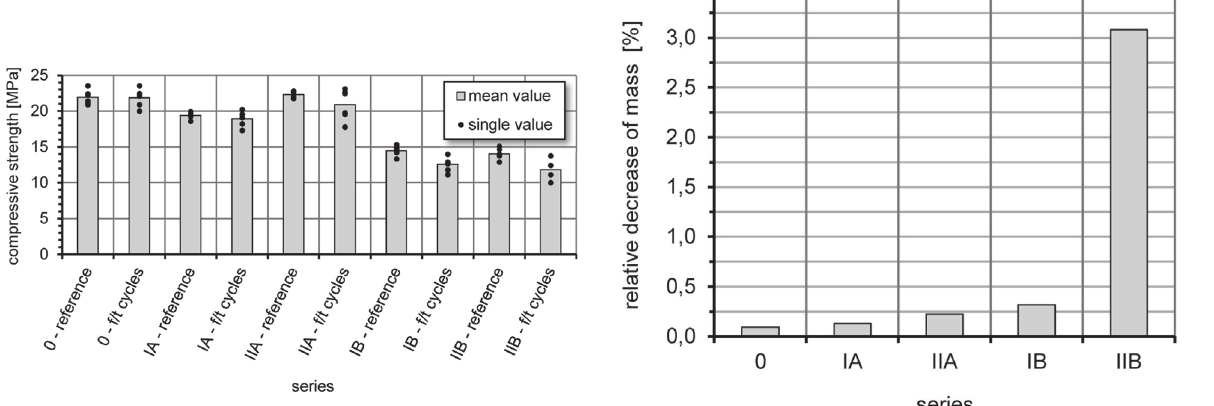
Figure 4: Mean differences between masses of specimens.